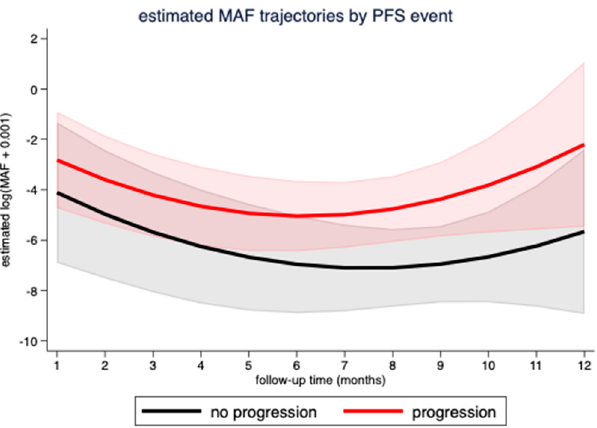
Figure 5. Evolution of MAF levels over followup time in patients with or without progression under treatment. Data are from a mixed model using 74 MAF measurements from 15 patients. MAF: mutant allele frequency; PFS: progression-free survival.